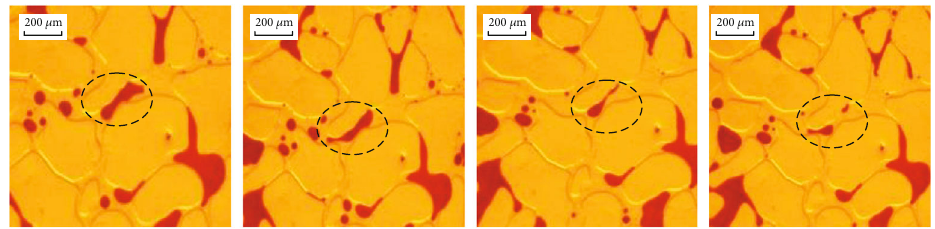
Figure 15: Schematic diagram of the displacement process of columnar residual oil (oil in pores is indicated by the red color).